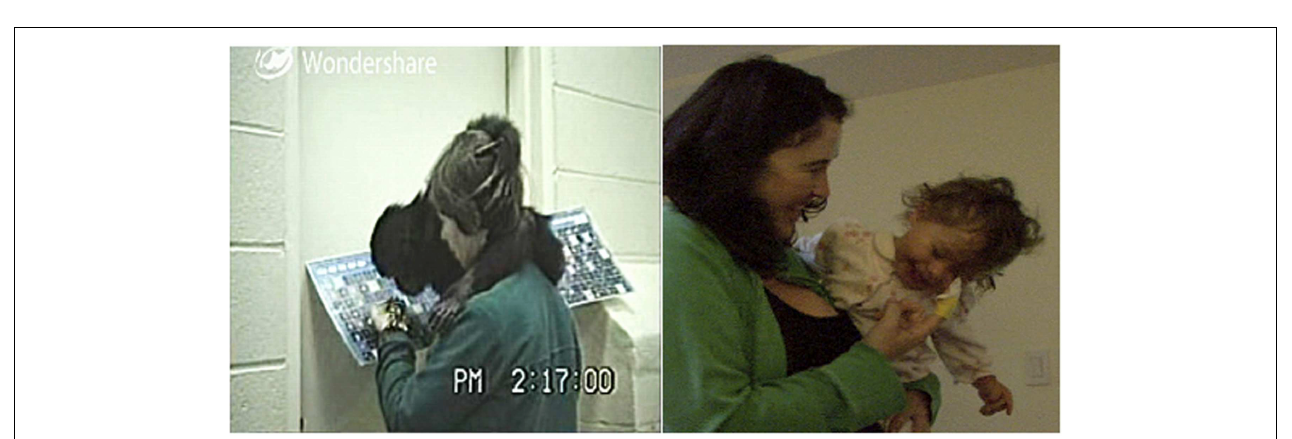
FIGURE 5 |An example of a point-touch gesture by an ape and a human. Point-touch is a point wherein the participant ends the point by touching the referent without moving her finger along it or manipulating it. Left: ape example – Sue, the caregiver, and Panpanzee were walking around Sue’s house, and Panpanzee pointed toward the picture.They